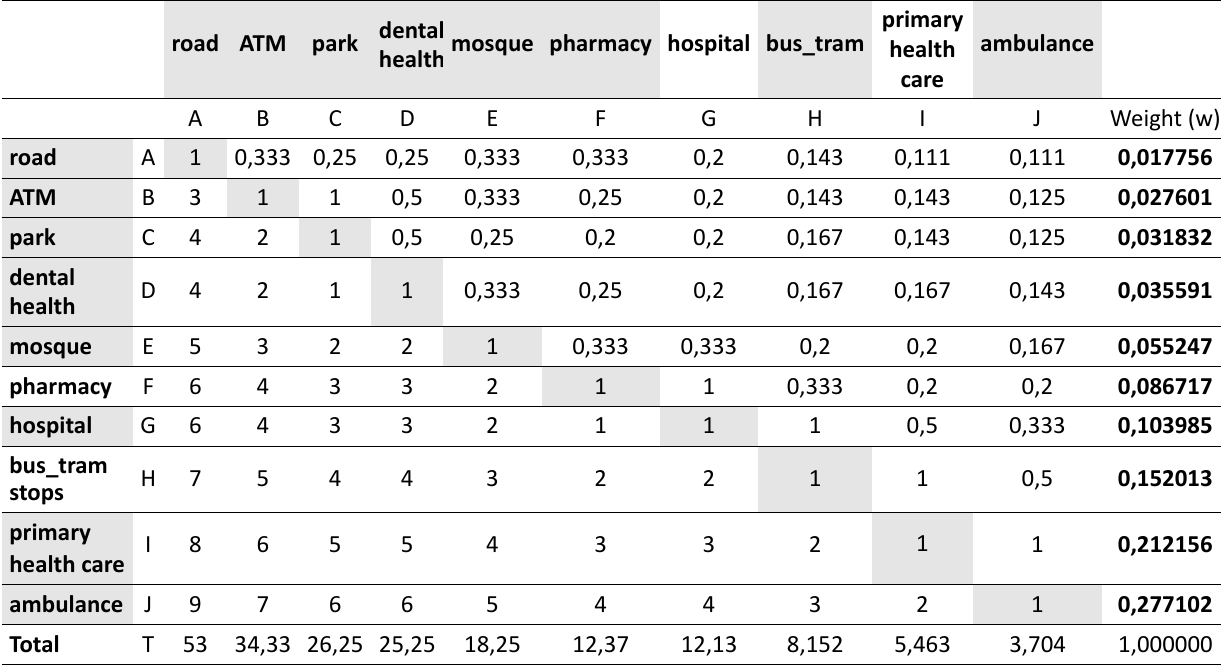
Table 2. AHP analysis of the criteria.